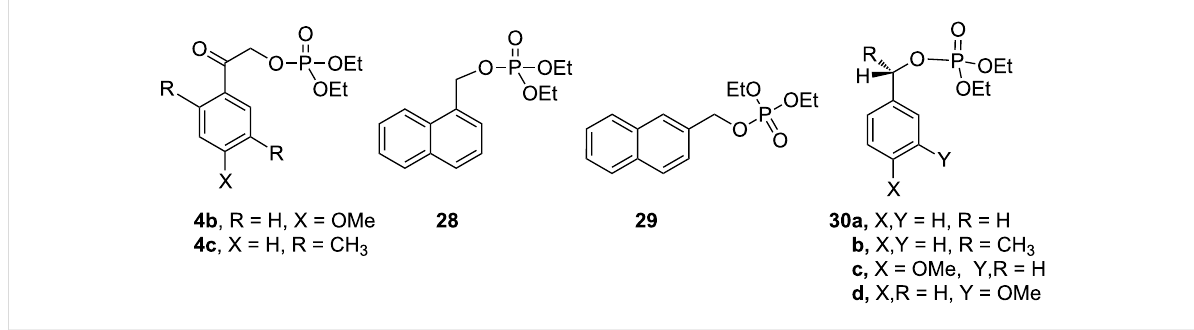
Figure 4: Previously studied caged diethyl phosphate PPGs possessing aromatic (benzyl, phenacyl, and naphthylmethyl) phosphates.